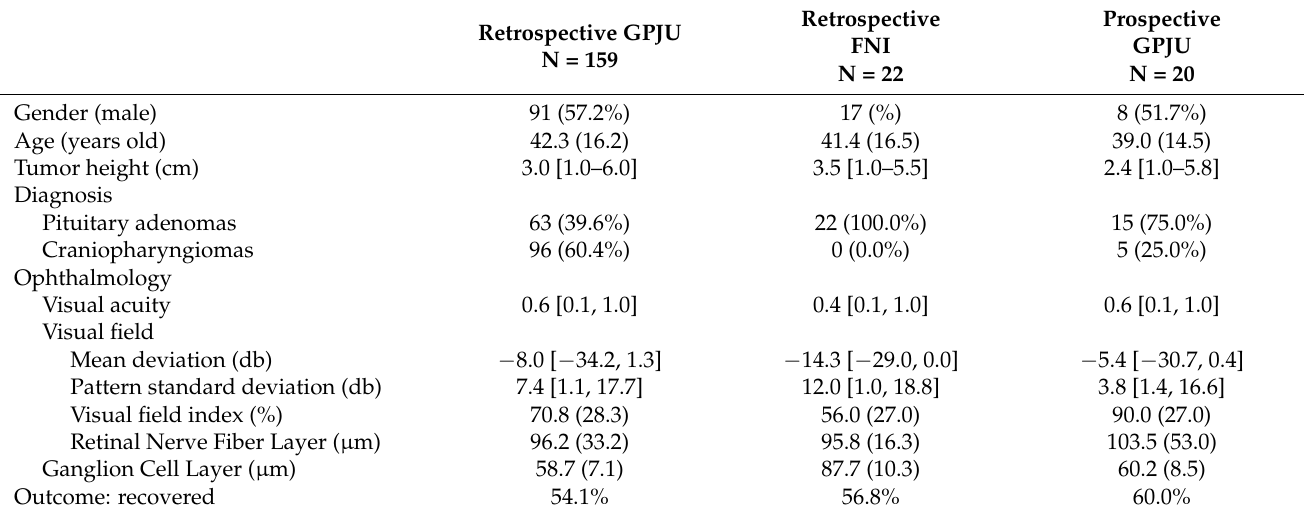
Table 4. Comparison among three